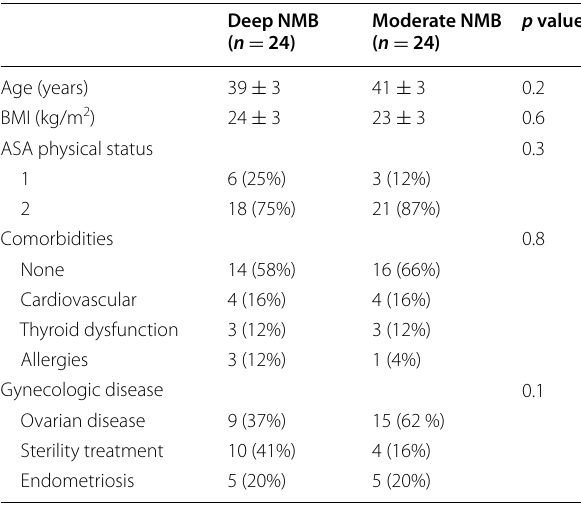
Values are mean, standard deviation (SD) or number of patients (proportion, % ASA American society of anesthesiologists, BMI body mass index, NMB neuromuscular block Boldface data, statistically